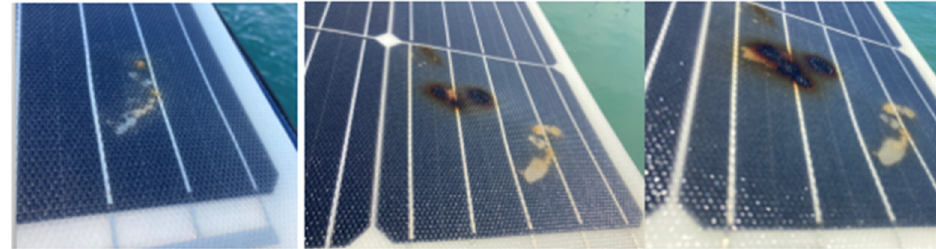
Figure 20. Development of hot ‐ spots after three days of continuous use.